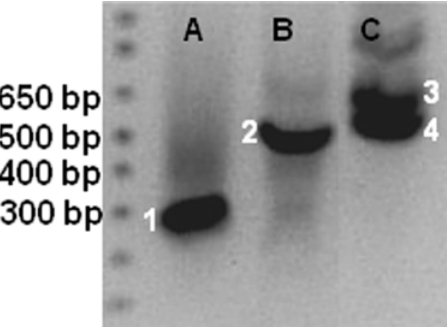
Figure 2. PCR amplified T-DNA right border/plant junction bands using genome walk procedure [Siebert et al. 1995]. Lanes A- LS1 / Dra I; B- LS1 / Eco RV; C- LS3 / Stu I. Each numbered band is cloned and sequenced. Bands 1 and 2 are identical so only sequence from 2 is used. But 3 and 4 are different, probably representing two different insertions in LS3 . Sizes of molecular weight marker are indicated to the left.